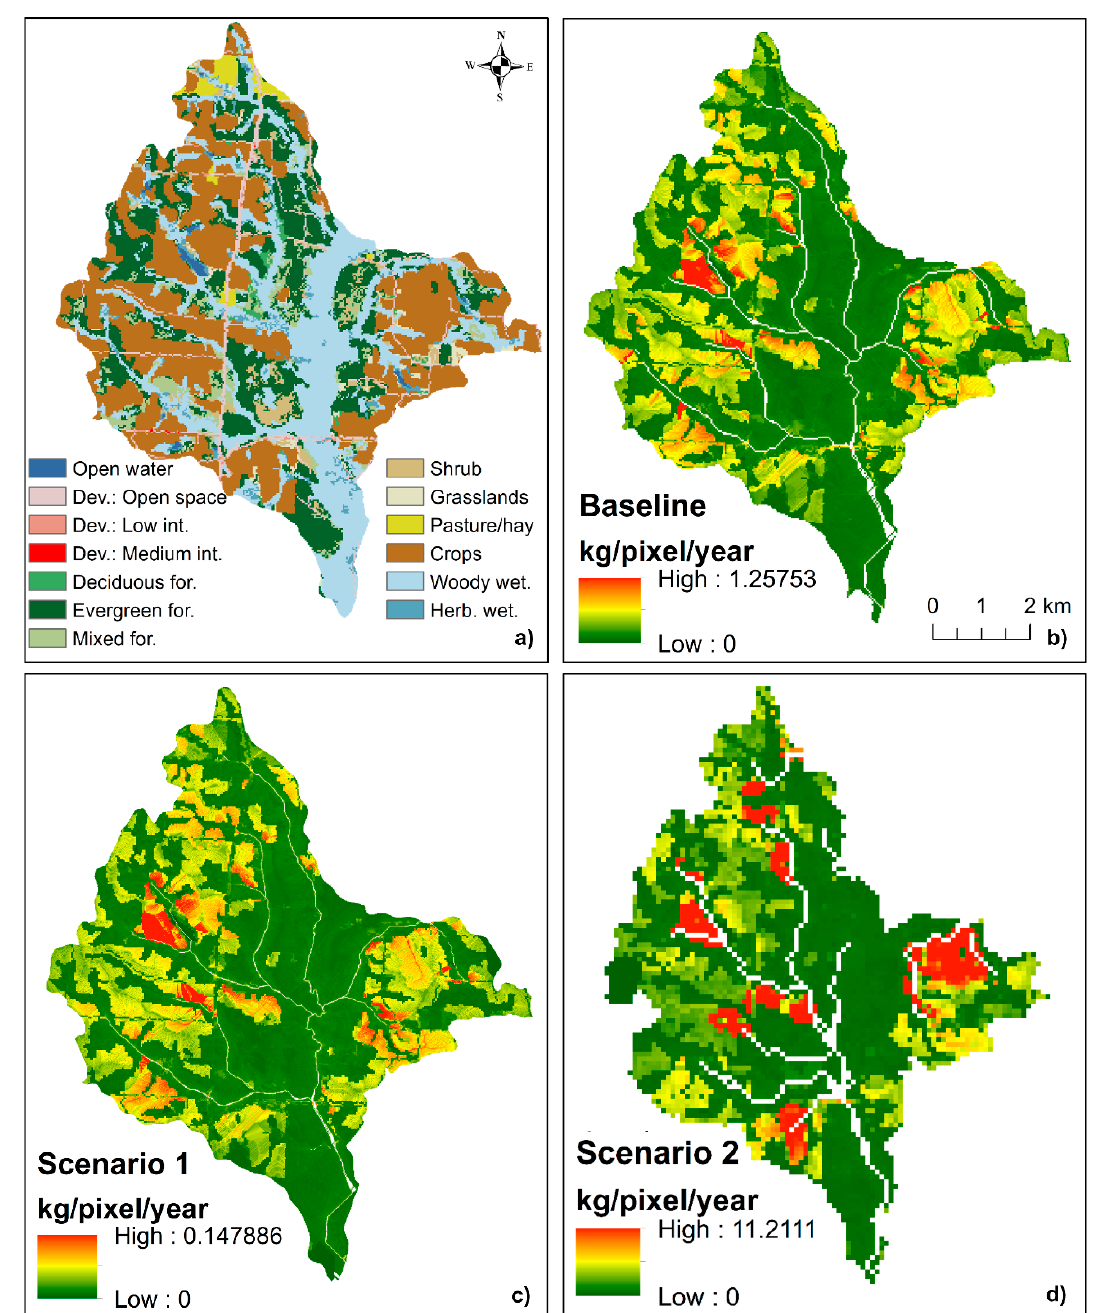
Figure 6. Land cover of the Griffin Lake–Ochlockonee River watershed according to the NLCD ( a ), and the outputs of the NDR models for the Baseline ( b ), Scenarios 1 ( c ), and 2 ( d ) showing the nitrogen export (kg/pixel/year) to water streams within this watershed. Figure 6a,b have a spatial resolution of 30 m, Figure 6c has a spatial resolution of 10 m, and Figure 6d has a spatial resolution of 90 m.